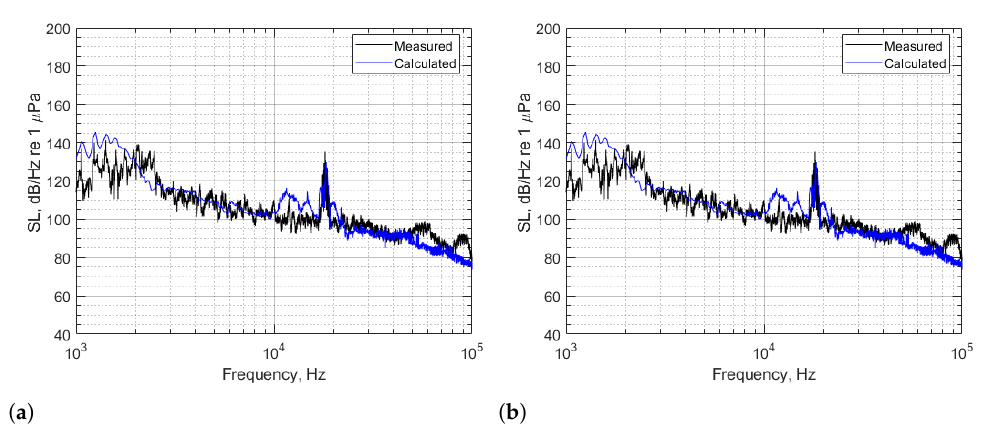
Figure 14. Comparison between the measured and calculated source levels for conditions ( a ) C 2 and ( b ) C 3.